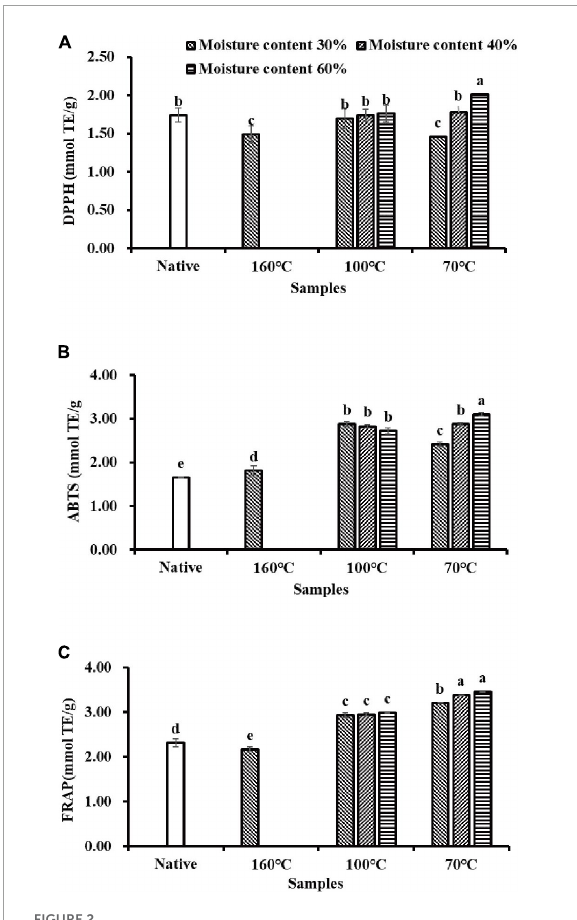
FIGURE2 The antioxidant activities of flavonoids extracts isolated from native and pregelatinized Tartary buckwheat flour: (A) 1,1-diphenyl-2-pic-rylhydrazyl (DPPH) radical scavenging activity. (B) ABTS radical scavenging activity. (C) Ferric reducing antioxidant power